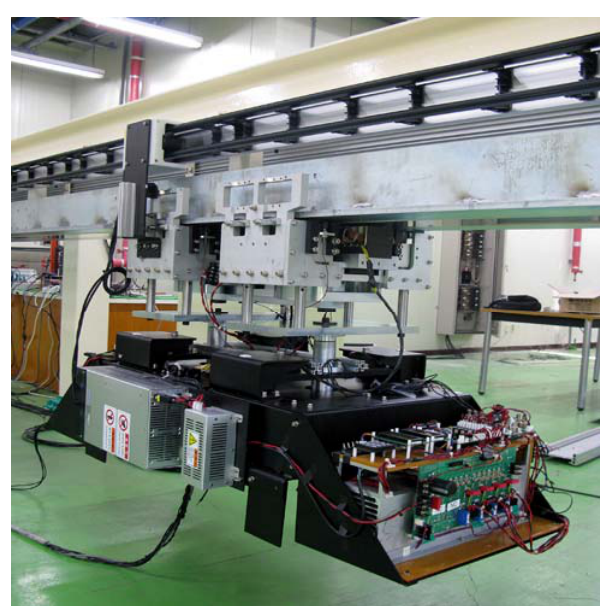
Figure 3. Application